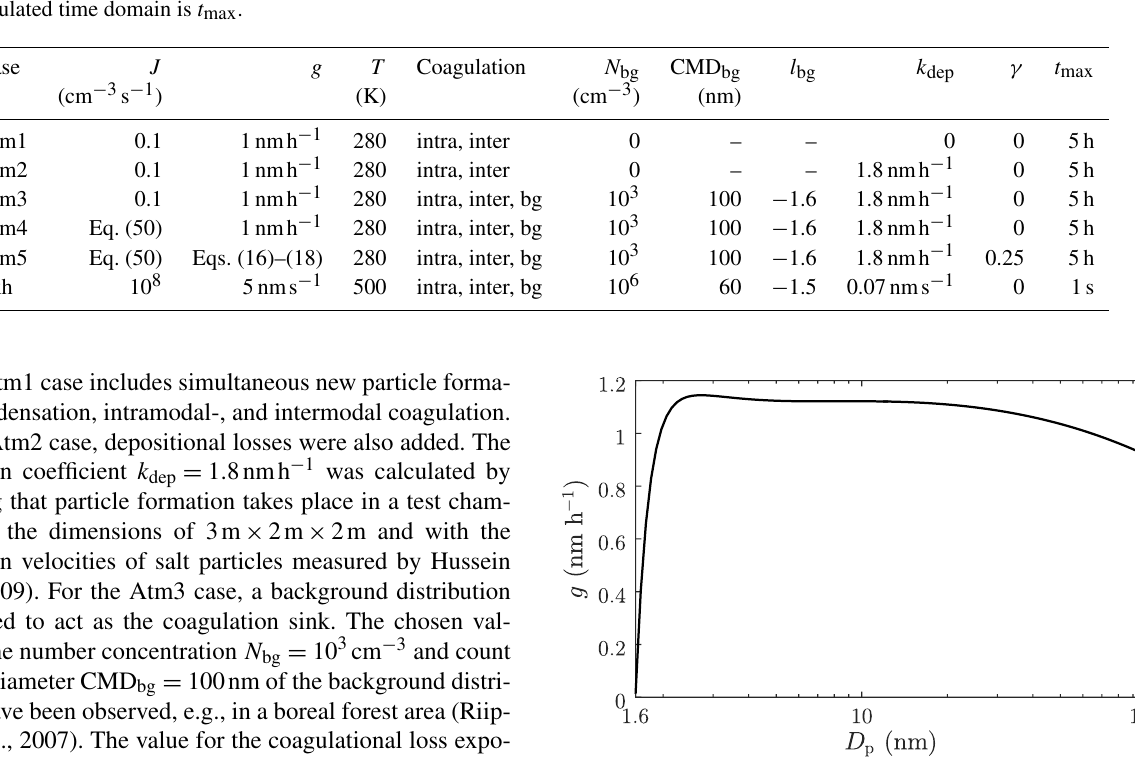
Table 1. Input parameters for the test cases. Case names with Atm have the parameter sets related to atmospheric particle formation and the Exh case related to particle formation occurring in vehicle exhaust. J and g are the new particle formation rate and the condensational growth rate, respectively. N bg is the concentration of the background aerosol distribution having a count median diameter of CMD bg . The coagulational loss exponent l bg depends on the value of CMD bg . Wall deposition is modeled using the deposition coefficient k dep . The length of the simulated time domain is t max .